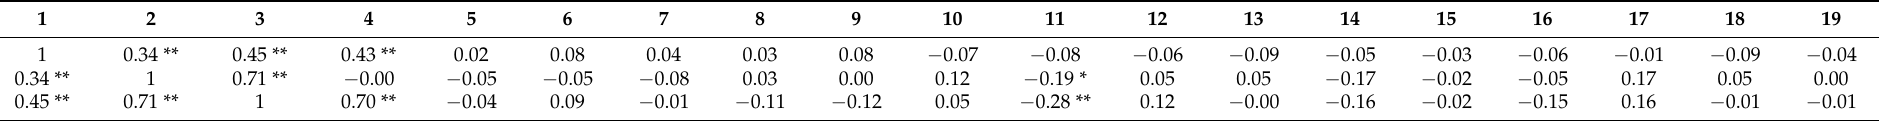
Table 3. Correlations between suicidal risk, anxiety, and daily stress, prosociality, perceived emotional intelligence, empathy, and prosocial trend measures.